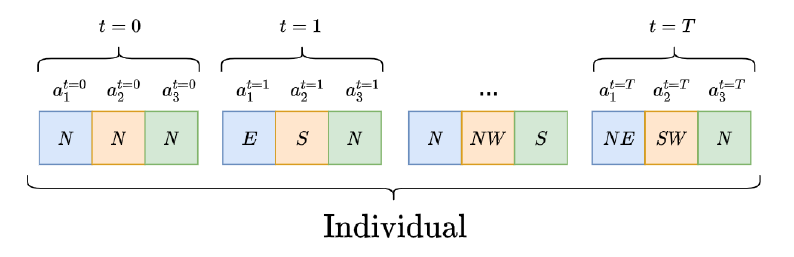
Figure 9. The multi-agent individual representation for F s = 3 agents. Actions are grouped three by three for every timestep t ∈ [ 0, T ]